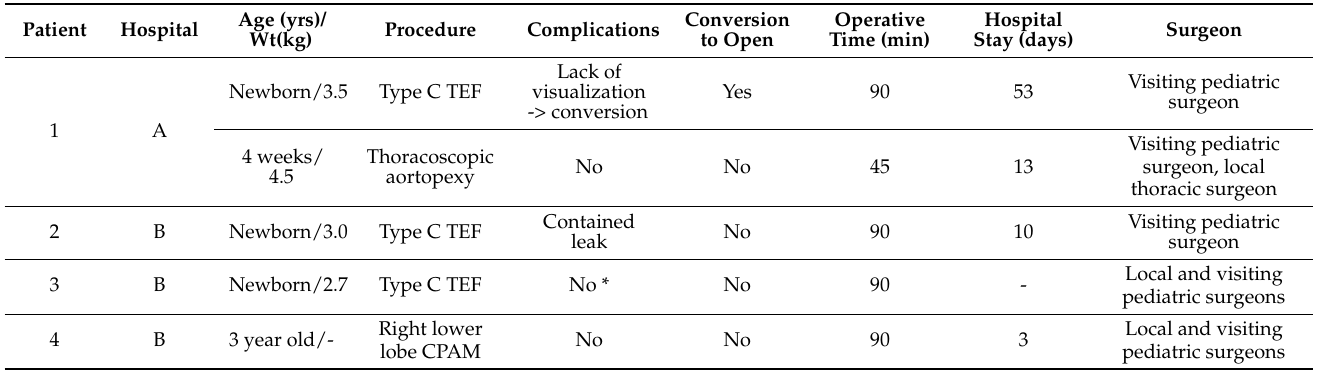
Table 2. Clinical and Perioperative